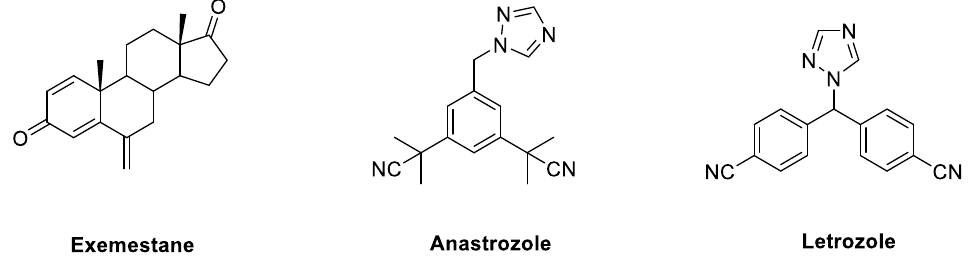
Figure 6. Marketed third generation aromatase inhibitors (AIs). These drugs feature either a steroidal (exemestane) or nonsteroidal (anastrozole and letrozole)